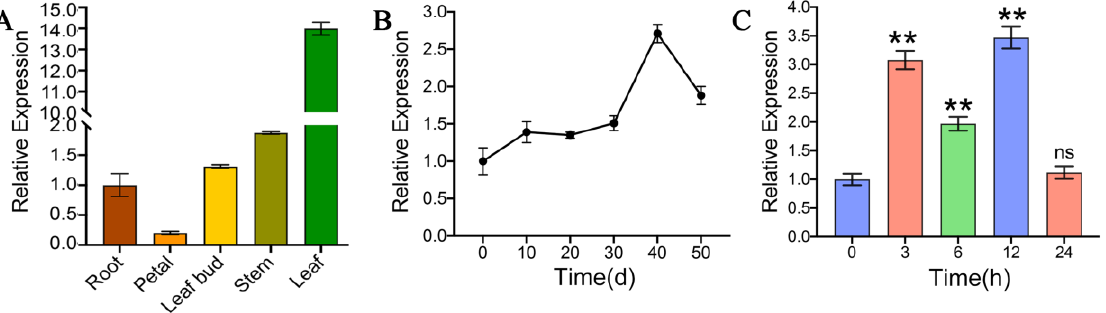
Figure 3. Expression analysis of OfELF3 . ( A ) Expression of OfELF3 in different tissues of O. fragrans . ( B ) Expression of OfELF3 at different developmental stages of flower bud in O. fragrans. ( C ) Expression of OfELF3 under 250 mM NaCl treatment in O. fragrans . The error bars indicate the SD values from at least three repeats of each treatment. ** p < 0.01, ns: no significant, t test.